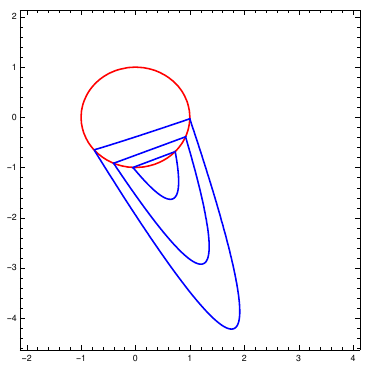
Figure 3. Three crossing limit cycles of PHS intersecting the ellipse at two